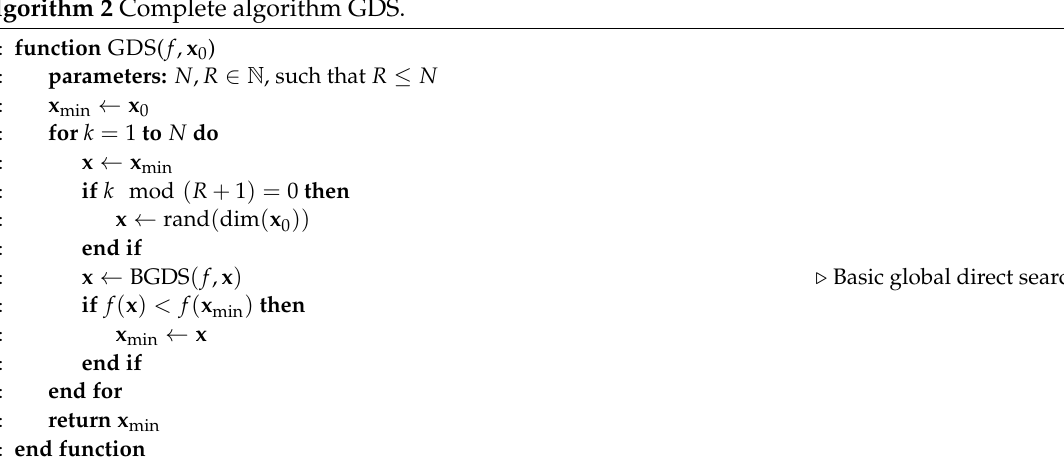
Algorithm 2 Complete algorithm